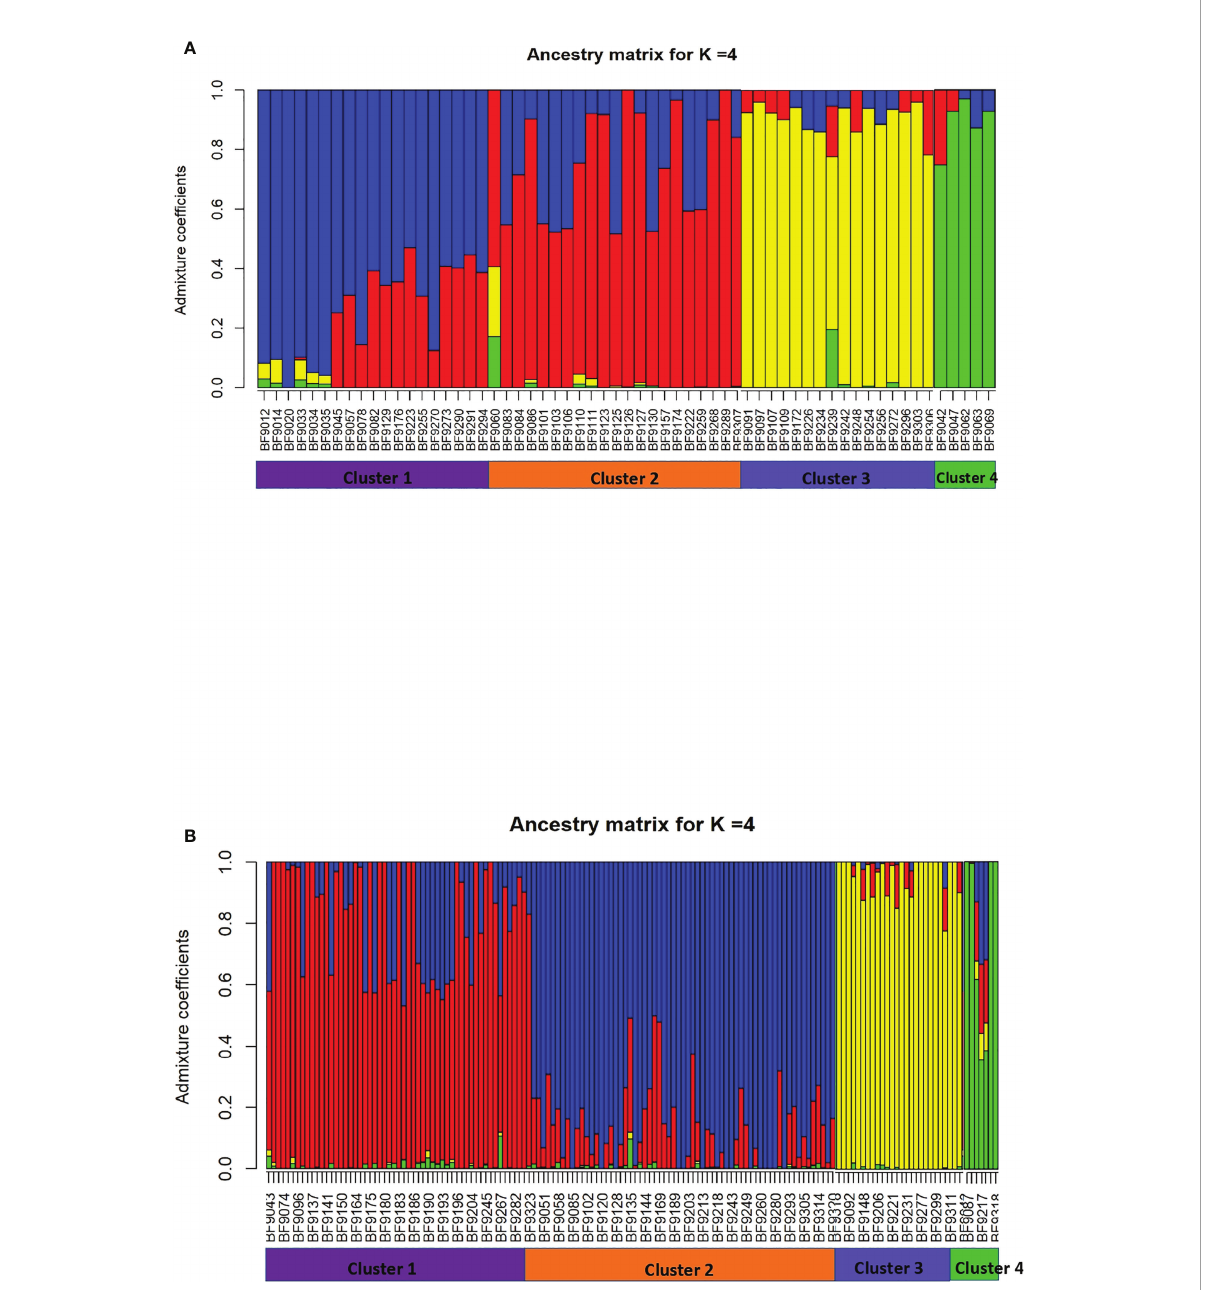
FIGURE 3 Population structure analysis of Bipolaris oryzae and Exserohilum rostratum . Ancestry coef fi cient for each isolate calculated by using sNMF with K=4. (A) B. oryzae , (B) E. rostratum.